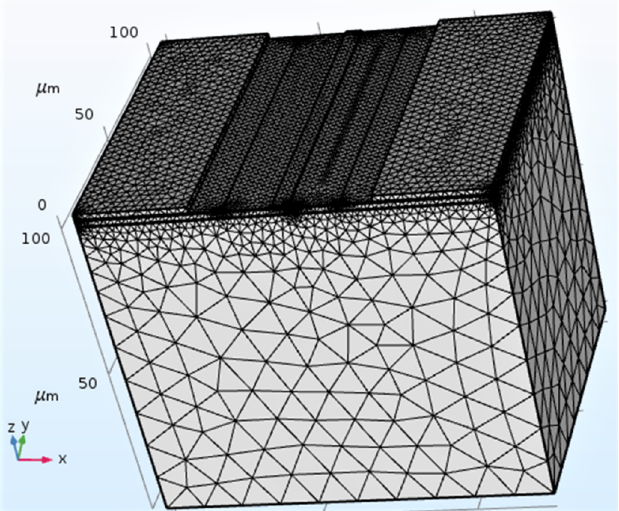
Fig. 2. The fi nite element model of the HEMT.